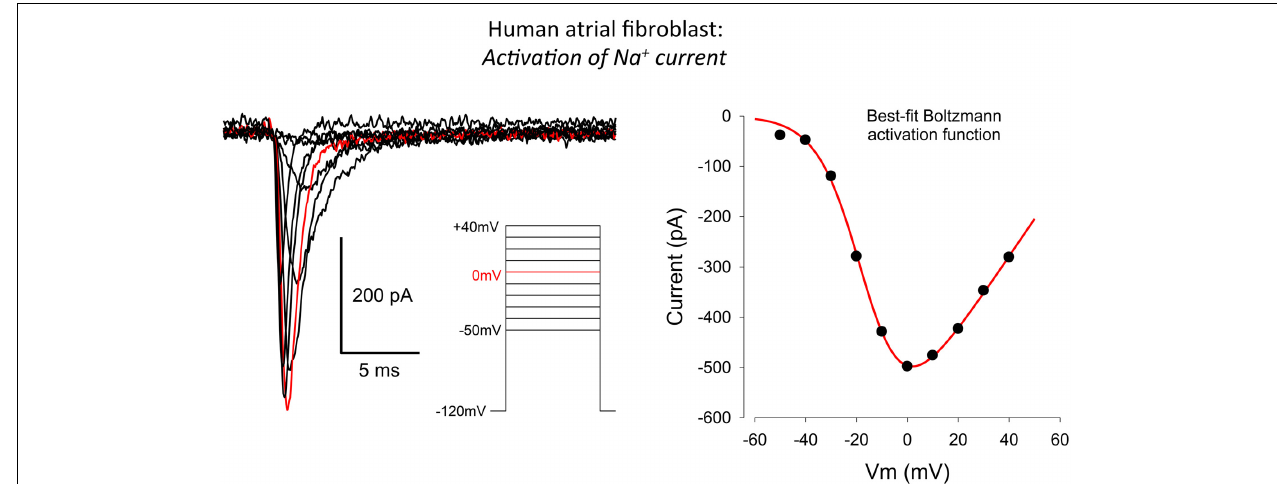
FIGURE 3 | Whole-cell voltage clamp records illustrating the activation of the transient inward Na + current in human atrial myofibroblasts. Raw data (10 superimposed current records) elicited by 100ms depolarizing clamp steps from − 50 to + 40mV are shown; the red trace indicates the current elicited at 0mV. The voltage clamp protocol is shown in the inset. The plot in